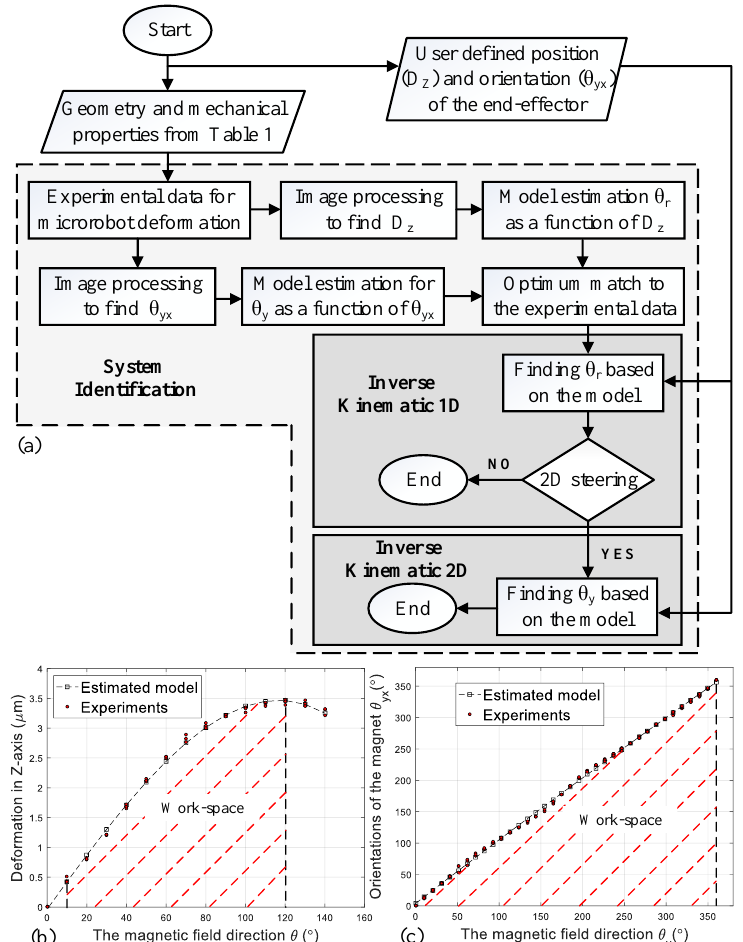
Figure 5. ( a ) The modeling algorithm for one dimensional (1D) and two dimensional (2D) steering; ( b ) the workspace for magnetic field direction θ r , and ( c ) θ y